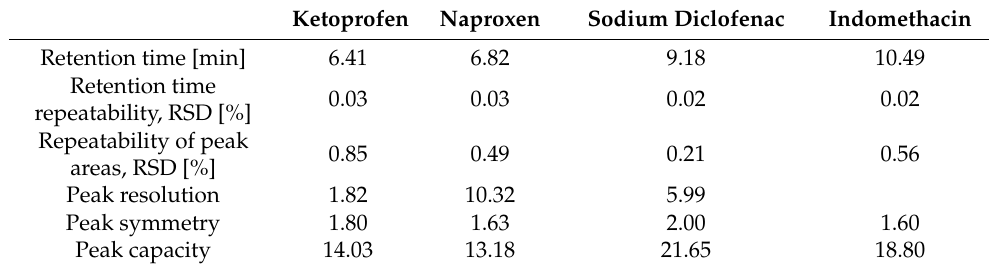
Table 1. HPLC system suitability parameters. Sample injection was performed in six